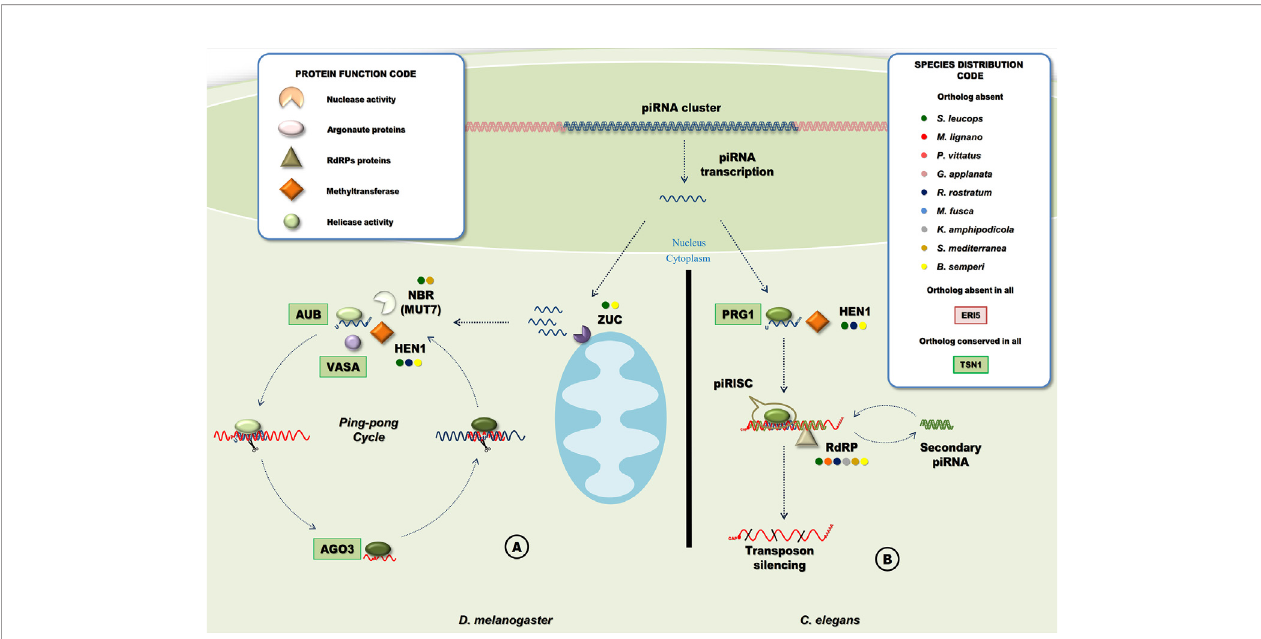
FIGURE 8 | Piwi-interacting RNA pathways. (A) PiRNA pathway in D. melanogaster . PiRNA precursors are cleaved by a protein of the mitochondrial membrane, Zucchini (Zuc) producing the primary piRNAs that are loaded into Aub, maturation of piRNA requires the 2-O methylation and cleavage of the piRNA 3 ’ end by HEN1 and NBR (MUT7), respectively. The primary piRNA and Aub form the piRISC, secondary piRNAs are generated in a slicer-dependent ampli fi cation loop that silence cytoplasmic TE transcripts named “ Ping-Pong ” cycle (To ́ th et al., 2016). (B) PiRNA pathway in C. elegans . In the cytoplasm, piRNAs are bounded by a PRG protein and methylated at the 3 ’ end by HEN1. The processed piRNA with PRG form the piRISC that will cleavage target RNA, target recognition is followed by the generation of secondary siRNAs mediated by RdRPs (Weick and Miska, 2014). Circles indicate species with missing homologous genes ( “ Species Distribution Code ” box). A ‘ shape ’ code was used to indicate predicted function of factors ( “ Protein Function Code ”